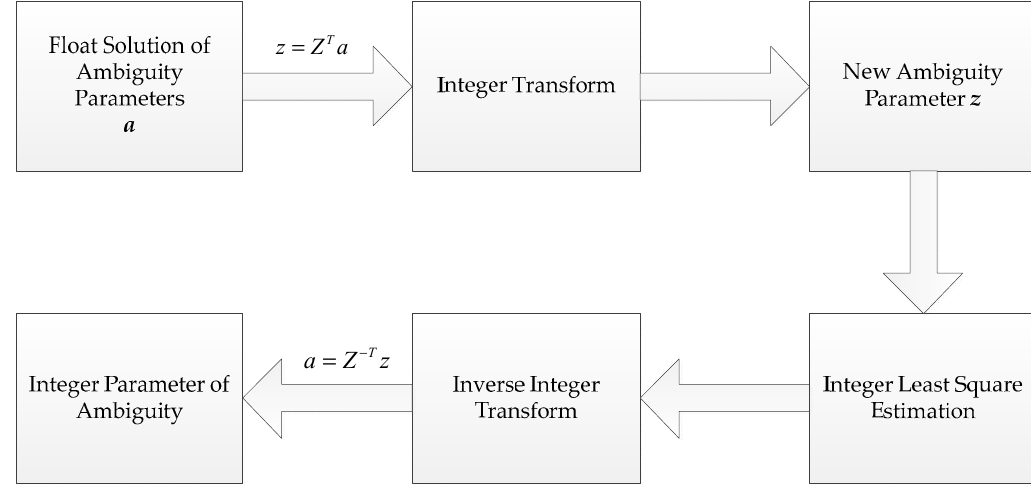
Figure 2. The process of fixing ambiguity by LAMBDA (Teunissen, 1995).